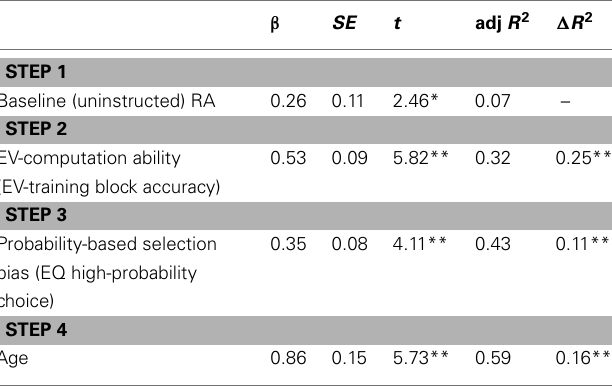
Table 4 | Hierarchical regression analysis of alternative explanations of relatively higher RA among older adults in instructed gambling including EV-selection ability and probability-based selection